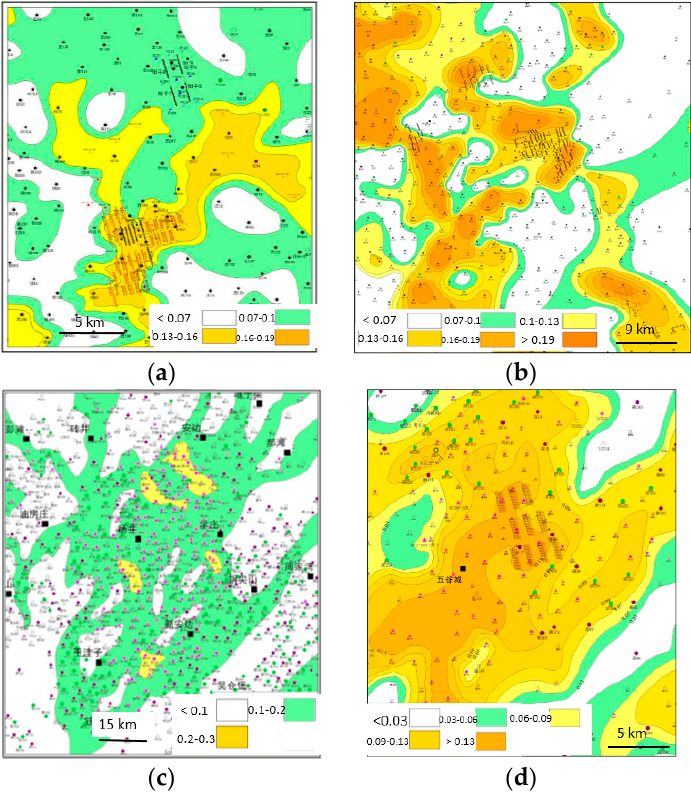
Figure 7. Permeability (mD) distributions of the four pilot areas in Chang 7: ( a ) Maling, ( b ) Heshui, ( c ) Jiyuan, ( d ) Ansai.